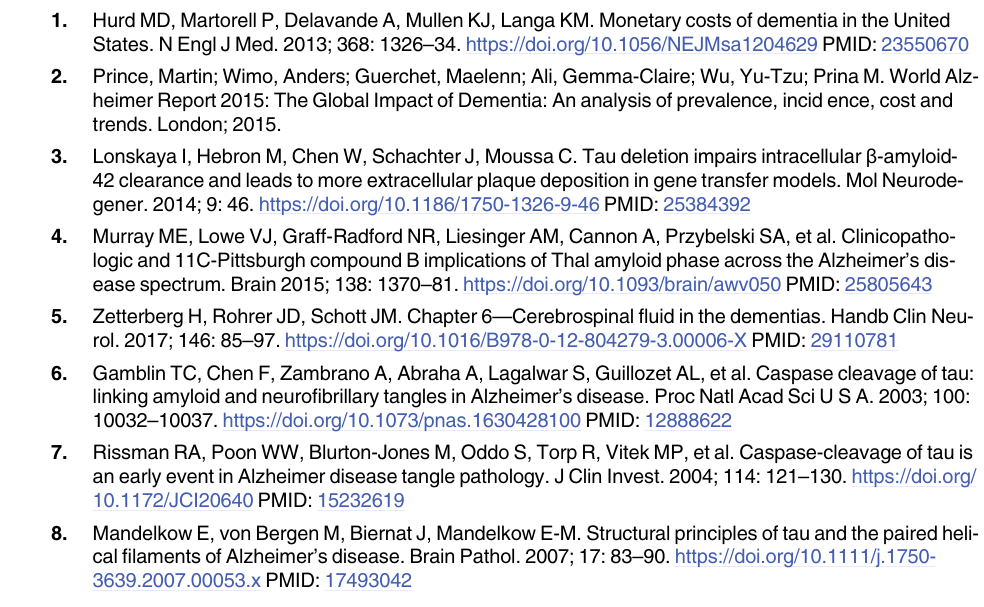
S1 Fig. Flow chart on sample inclusion and